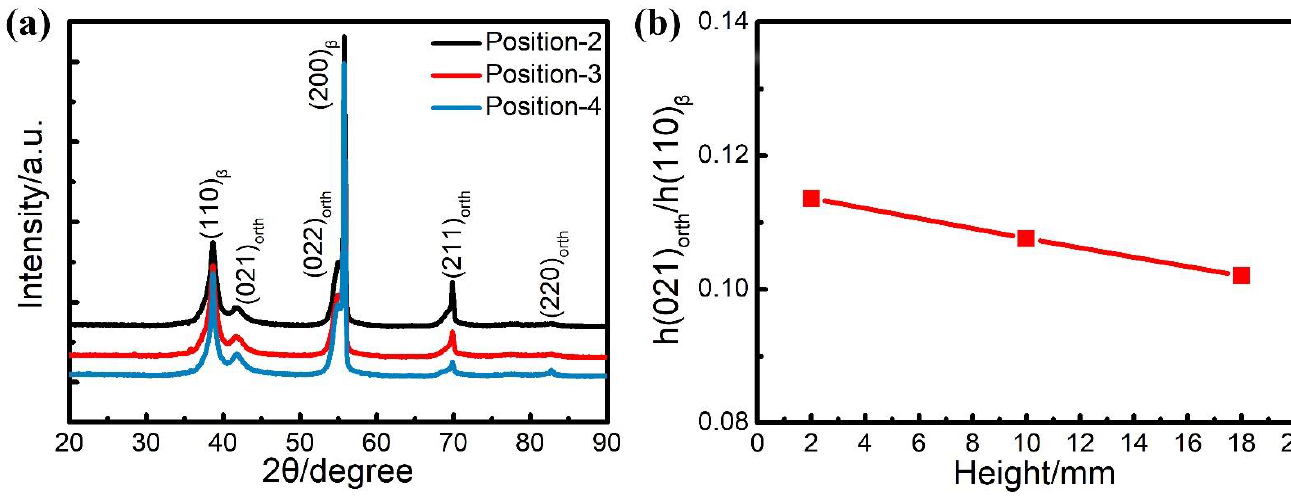
Figure 13. XRD analysis results of PBF-EB Ti2448 alloy at different heights. ( a ) XRD diffraction patterns of Ti2448 sample at positions 2–4 shown in Figure 2b. ( b ) The change of height ratios of diffraction peak (021) orth to (110) β along the height direction.